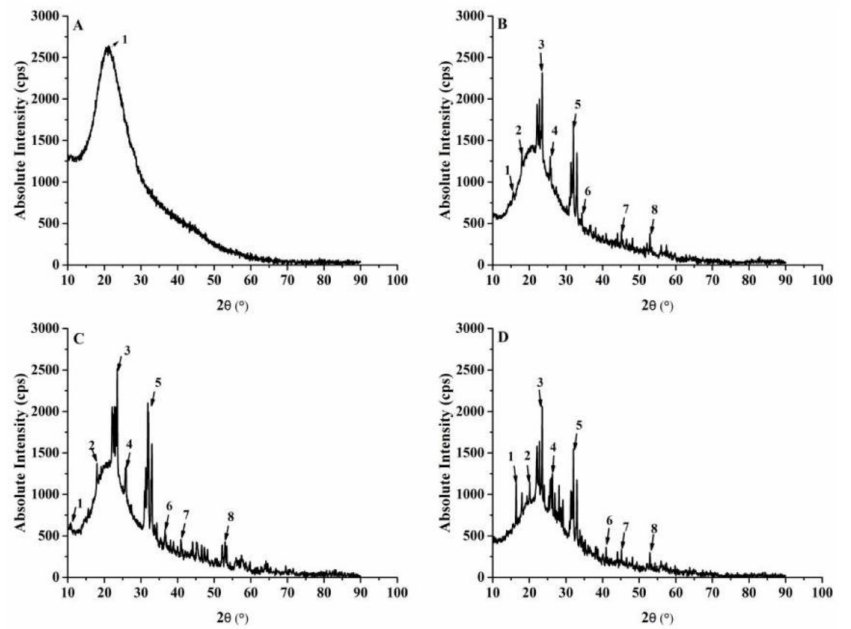
Figure 6. XRD diffraction patterns of COSs and COSs nano-liposomes. ( A ) COSs. ( B ) COSs-Lip. ( C ) CH-COSs-Lip. ( D )